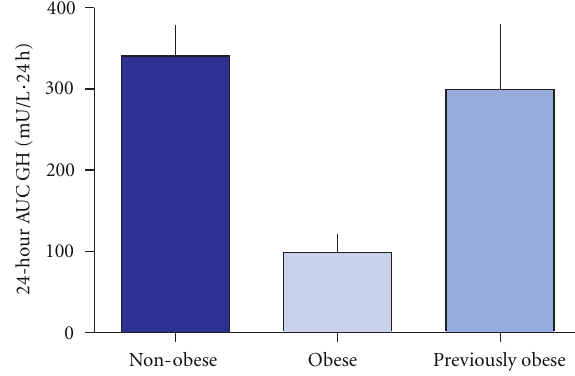
Figure 1: Sweat secretion rate. Columns represent (left to right) levels in non-obese ( n = 16), obese ( n = 16), and previously obese subjects ( n = 8).